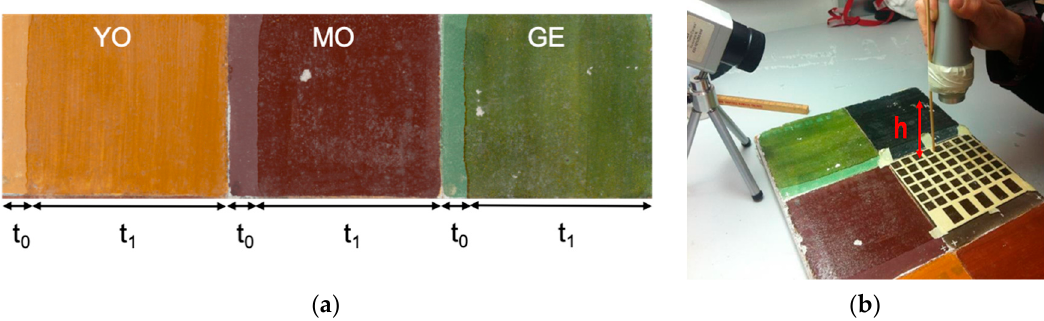
Table 1. Pigments and their acronyms used in the fresco mock-up.